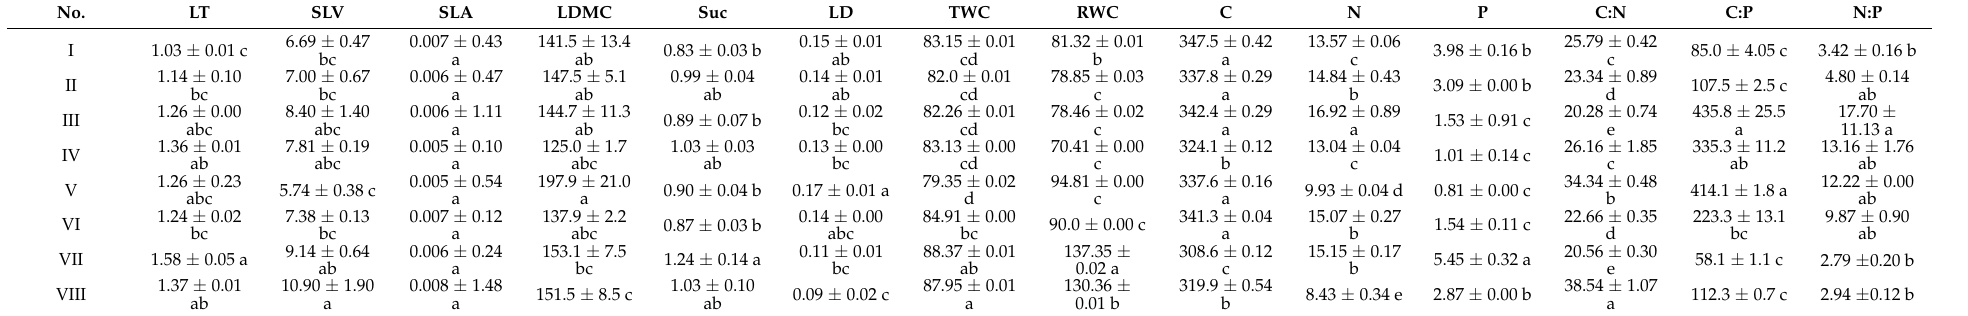
Table 2. Leaf functional traits of eight Lycium ruthenicum populations (Mean ± SD, n =